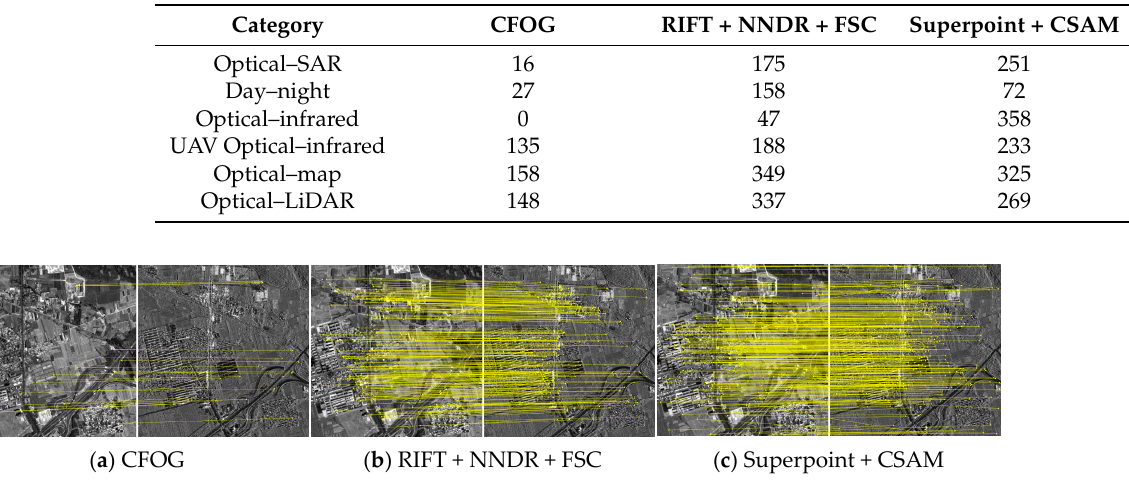
( c ) Superpoint + CSAM Figure 16. Optical–SAR matching results. ( a ) CFOG